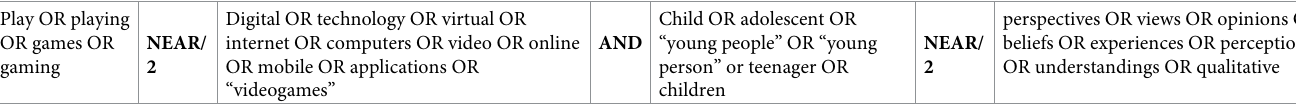
Table 1 for the final list of search terms. Research studies were restricted by publication in English (for pragmatic reasons) and limited to results within the last 15 years. Table 1. Search